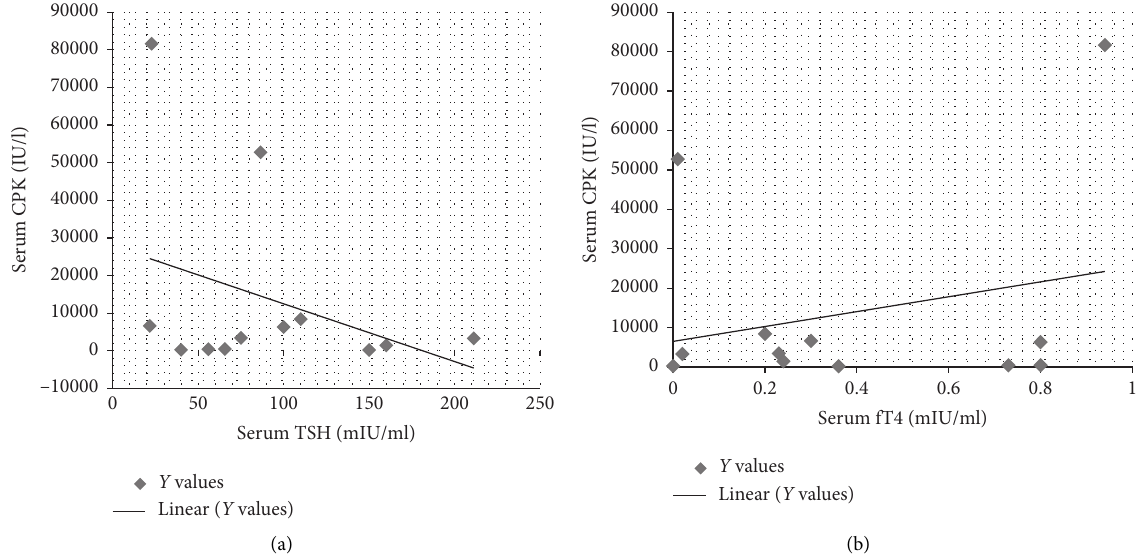
Figure 3: Correlation between serum TSH, fT4 levels, and serum CPK in the present study. CPK, creatine phosphokinase; fT4, free thyroxin; TSH, thyroid-stimulating hormone.